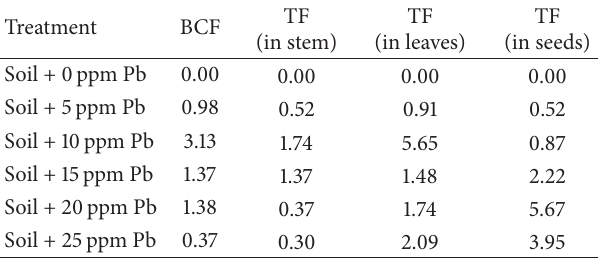
Table 3: Bioconcentration factor (BCF) and translocation factor (TF) of lead in Glycine max